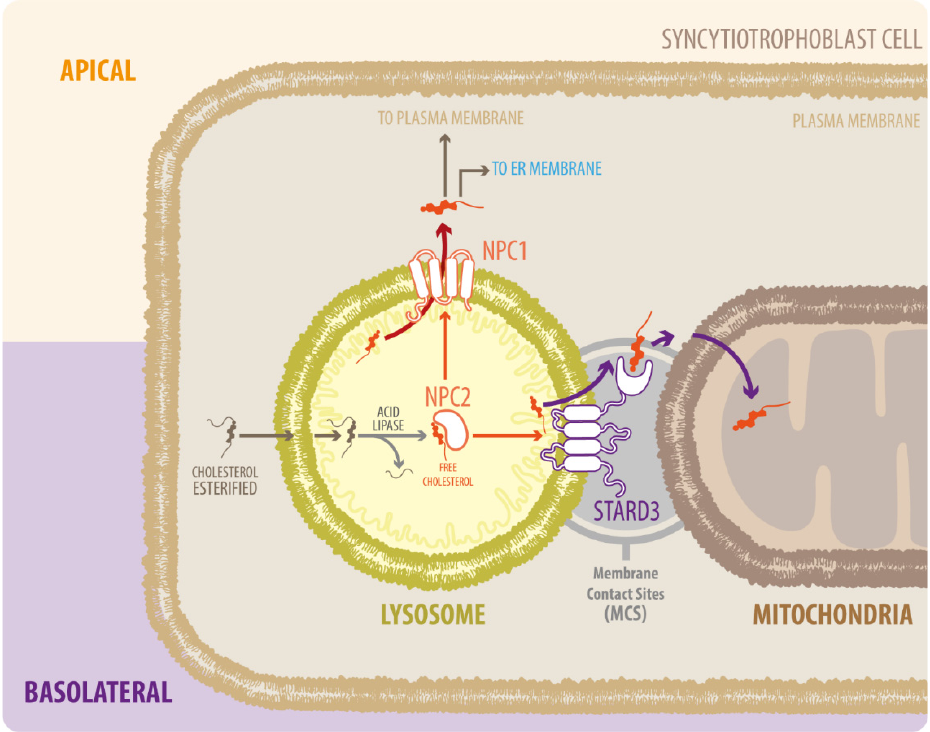
Figure 1. Diagram of NPC1, NPC2, and STARD3 proteins in LDL-derived cholesterol transport. Cholesterol from the endocytic pathway is hydrolyzed in the lysosome by acid lipase to form free cholesterol, which binds to NPC2 and is delivered to NPC1. NPC1 takes the cholesterol out of the lysosome via glycocalyx molecules on the internal surface of the lysosomal membrane. Cholesterol then moves to the endoplasmic reticulum (ER) and is distributed to the rest of the cell. Alternatively, NPC2 can transfer cholesterol from LE/LY directly to STARD3, which mediates transport to mitochondria; however, the exact mechanism by which this occurs is unknown.